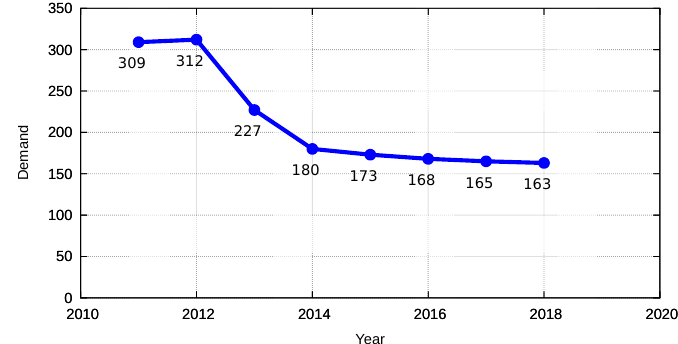
Figure 3. Estimated demand in the first option.